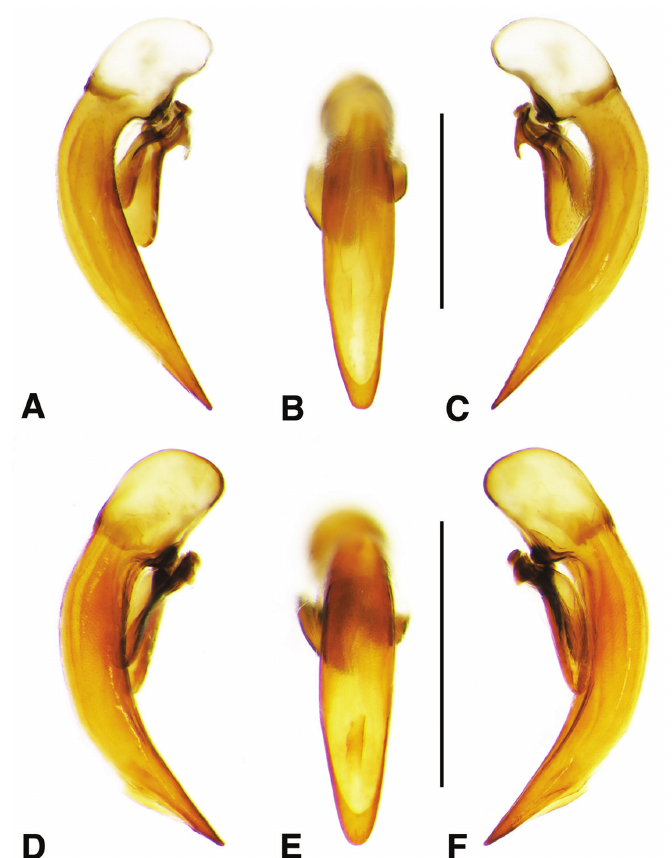
Figure 68. Digital images of male genitalia of Discoderus species, A and D right lateral aspect B, E dorsal aspect C and F left lateral aspect. A–C D. cyaneopacus (Darlington) D–F D. thoracicus (Putzeys). Scale bars 1 mm. lateral surface of pronotum and elytra with mesh pattern isodiametric; pronotal disc